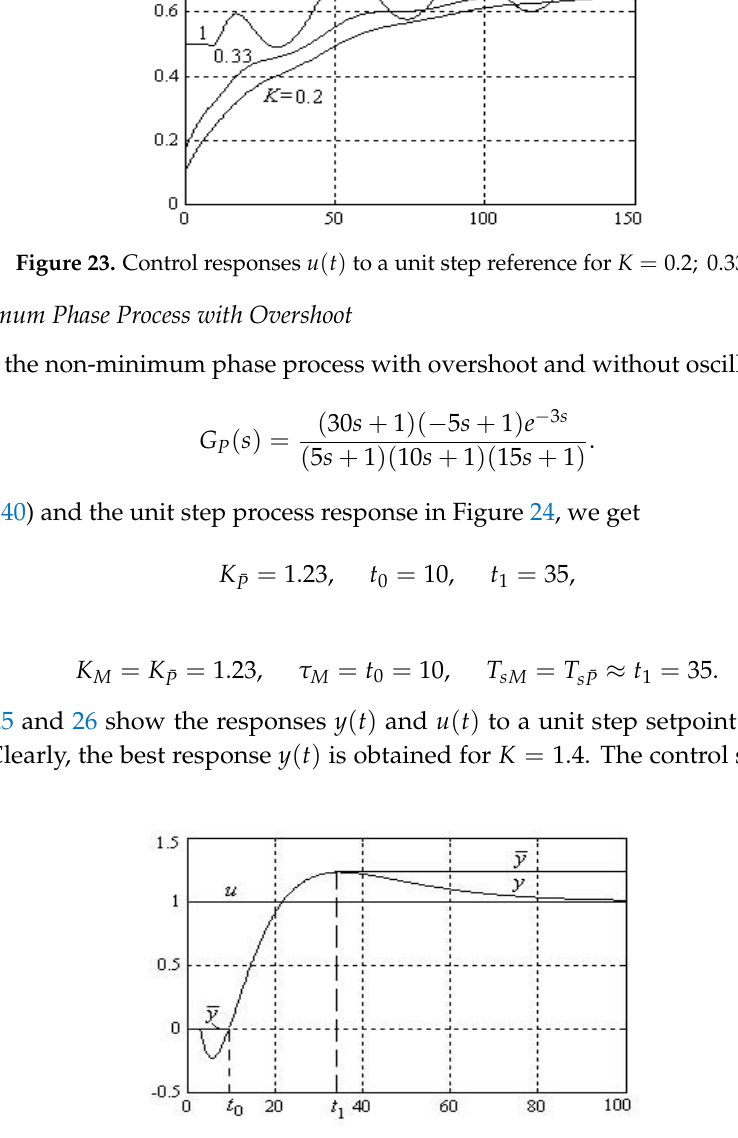
Figure 24. Process response to a unit step